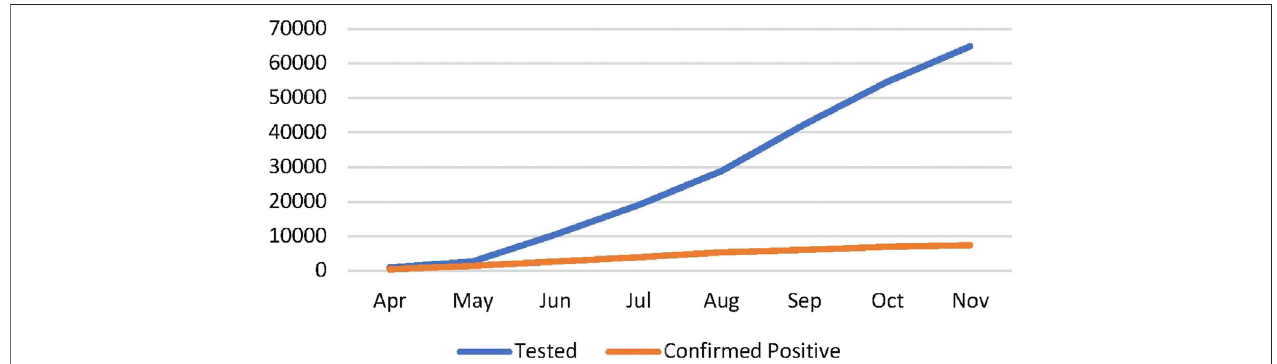
FIGURE 1 | COVID-19 Testing of Immigration Detainees, April-November 2020. Source: COVID-19 ICE Detainee Statistics, available at “ https://www.ice.gov/ coronavirus ” and archived versions of that webpage.